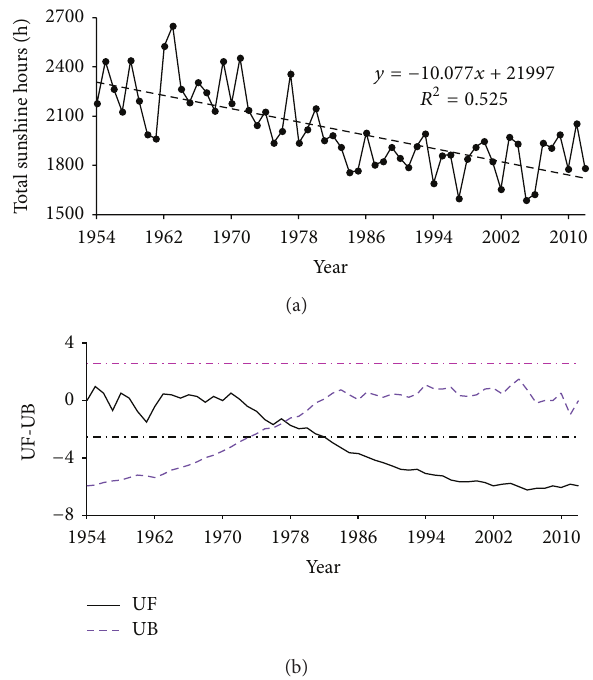
Figure 2: Temporal change in the yearly sunshine duration (a) and the trend results from the Mann-Kendall method (b).